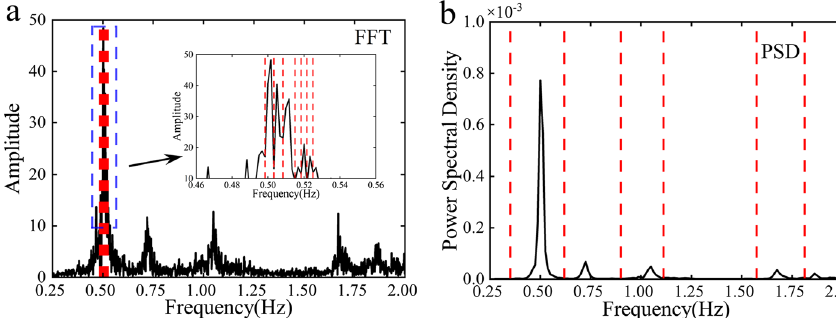
Fig. 10 Comparison results between two bases for dividing frequency band boundary: a Fourier spectrum; b Power spectral